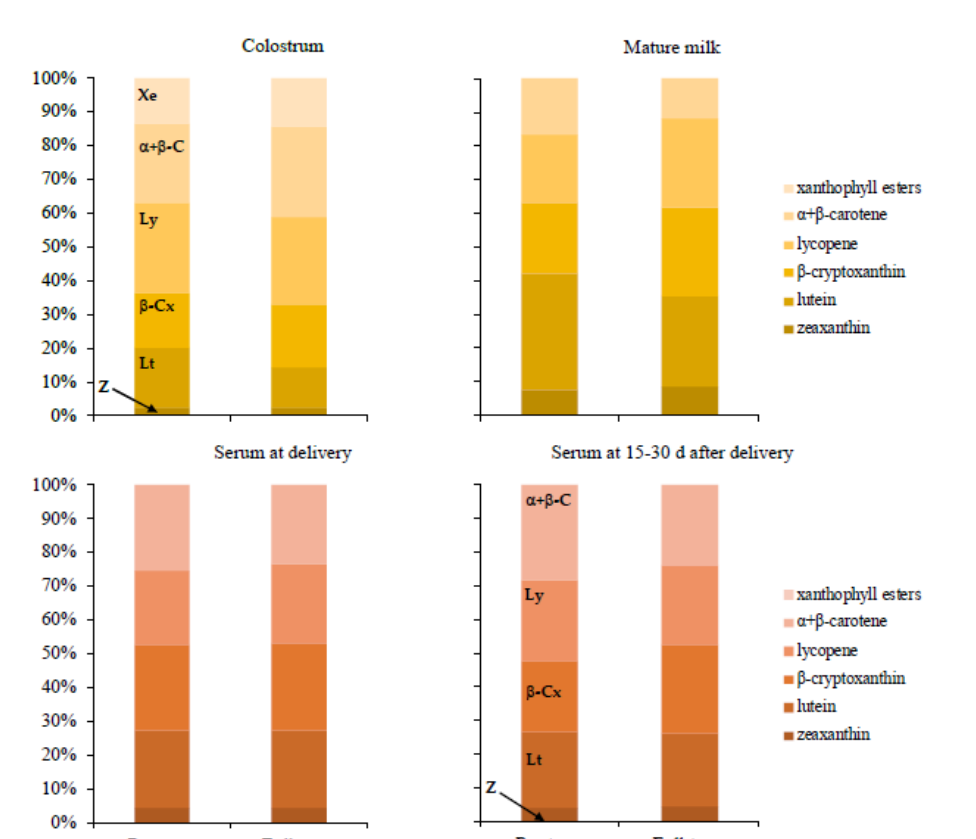
1: No significant differences were observed for data of both groups of lactating mothers or at each collection time within a group.